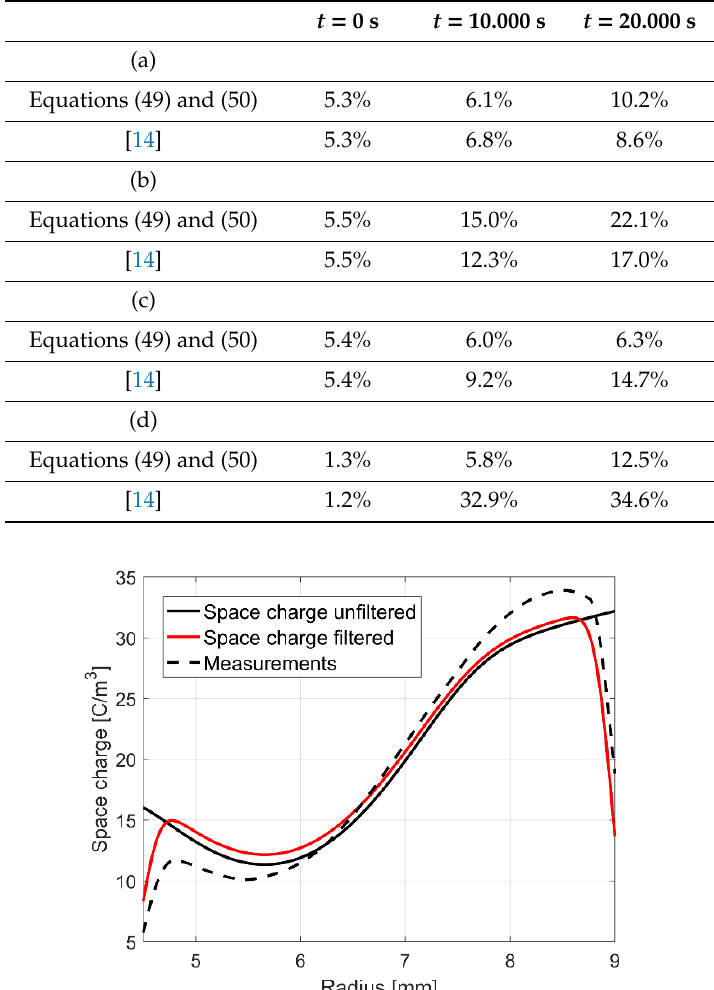
Table 4. Mean di ff erence between the simulated and the measured electric field, using (49) and (50) and the results in [14,95].